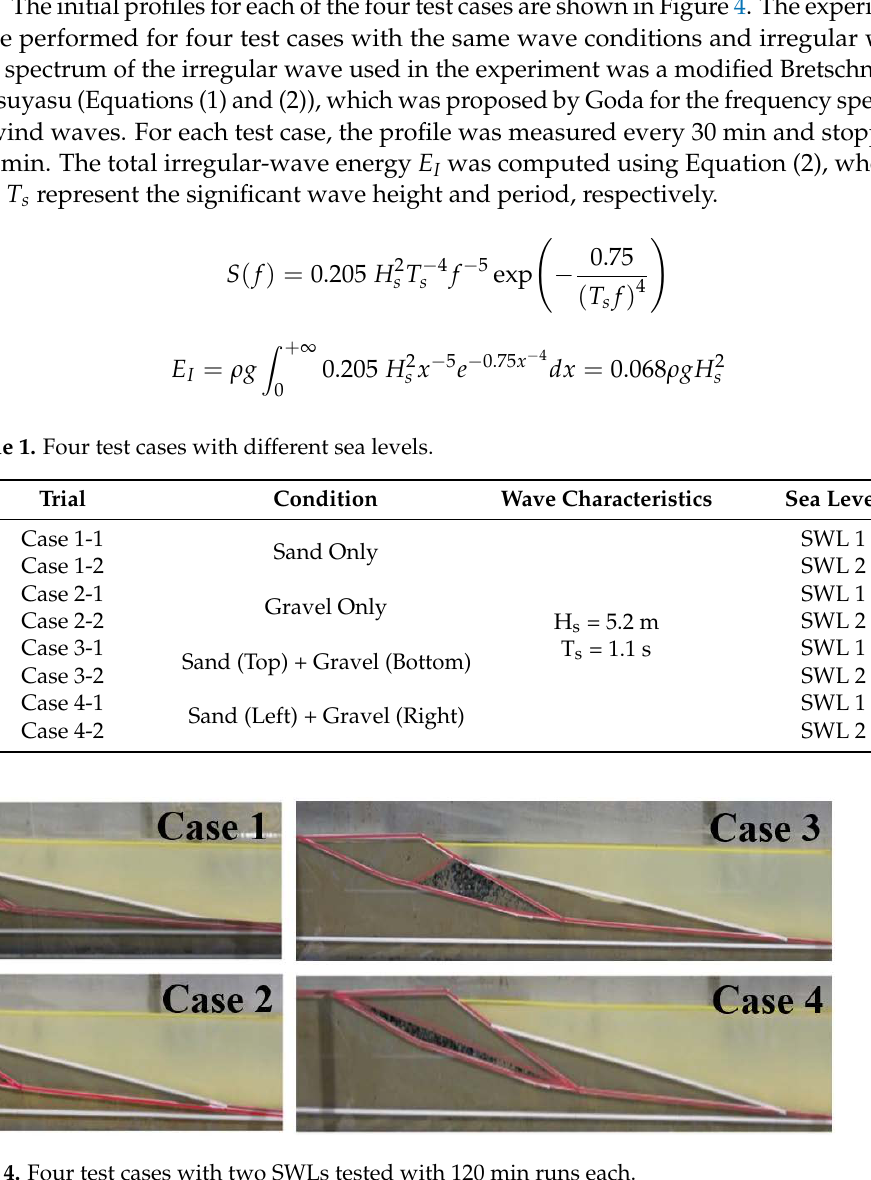
Figure 3. Wave height at the lagoon side during the monitoring period.